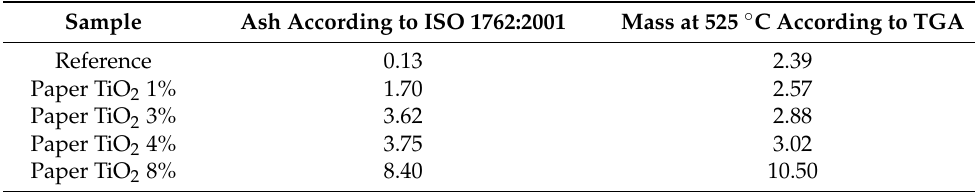
Table 1. Data obtained from TGA analysis and International Organization of Standard (ISO) ash content for all